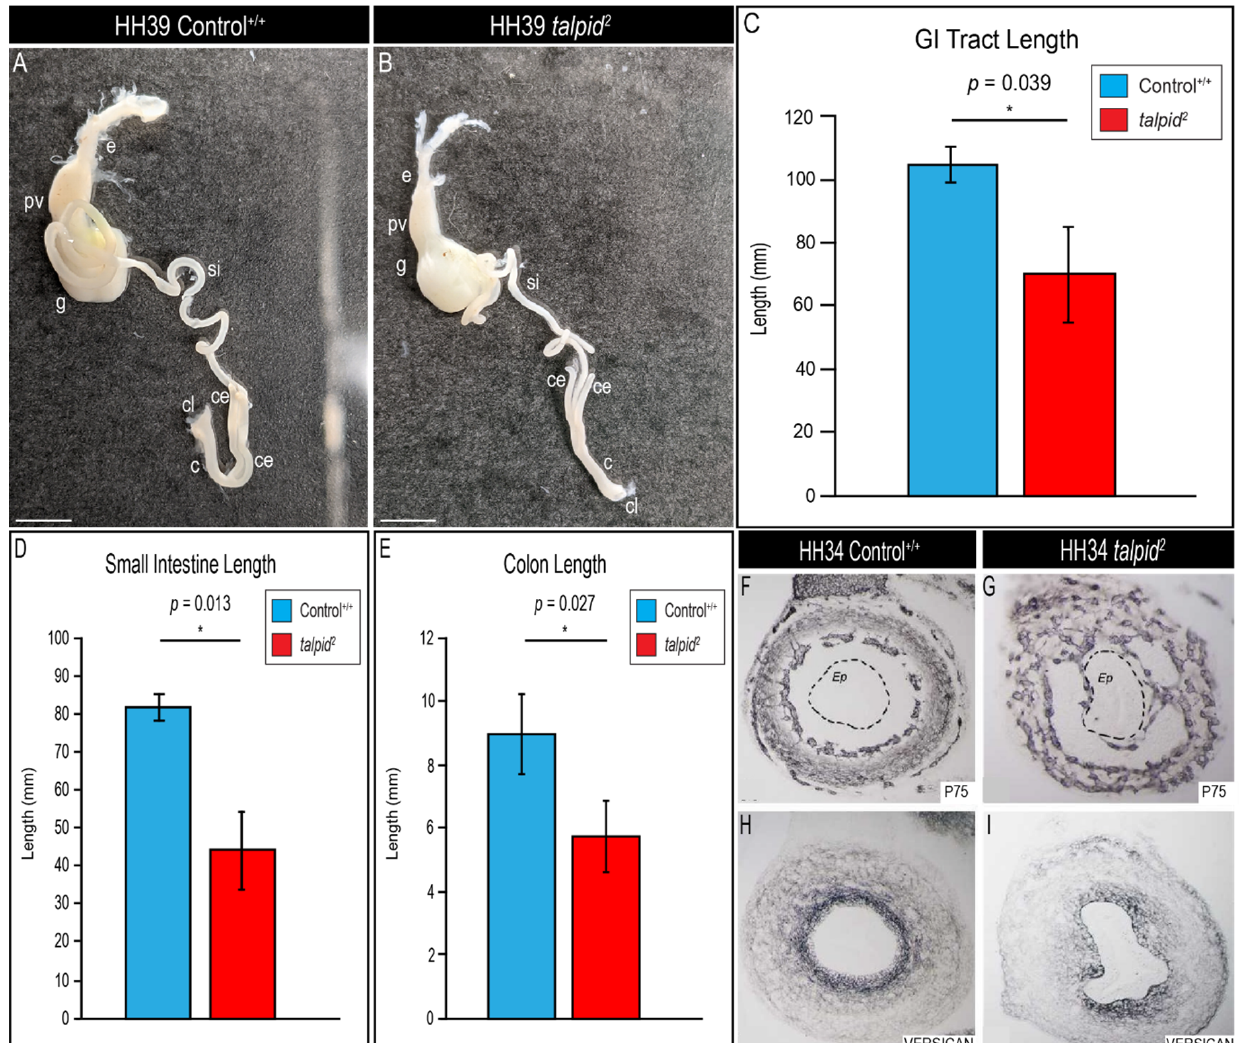
Figure 6. ta 2 embryos present with shortened gastrointestinal (GI) tracts accompanied with ectopic enteric neural crest cell (ENCC) migration. ( A , B ) Dissected gastrointestinal tracts from HH39 control +/+ ( A , n = 3) and ta 2 ( B , n = 3) embryos. ( C – E ) Length measurements of HH39 control +/+ and ta 2 ( C ) gastrointestinal tracts, ( D ) small intestines, and ( E ) colons. ( F – I ) Immunostaining for ( F , G ) P75 and ( H , I ) VERSICAN in transverse sections of HH34 control +/+ and ta 2 hindguts. Dotted black circles in ( F , G ) indicate the intestinal epithelium. c: colon, ce: cecum, cl: cloaca, e: esophagus, Ep: epithelium, g: gizzard, pv: proventriculus, si: small intestine. Scale bars: ( A , B ) 6 mm. Error bars represent the mean data ± s.d. Statistical analysis was performed utilizing Student’s t -test (* denotes p < 0.05).